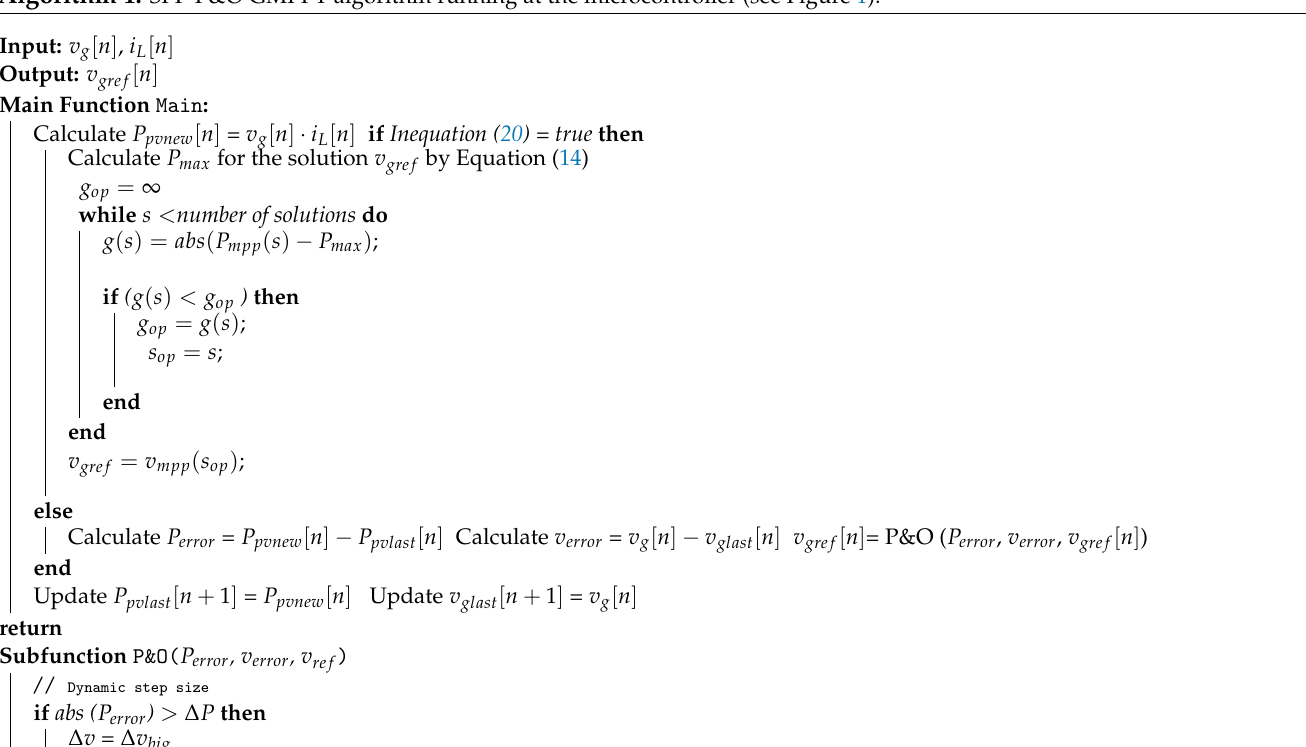
Algorithm 1: SPF-P&O GMPPT algorithm running at the microcontroller (see Figure